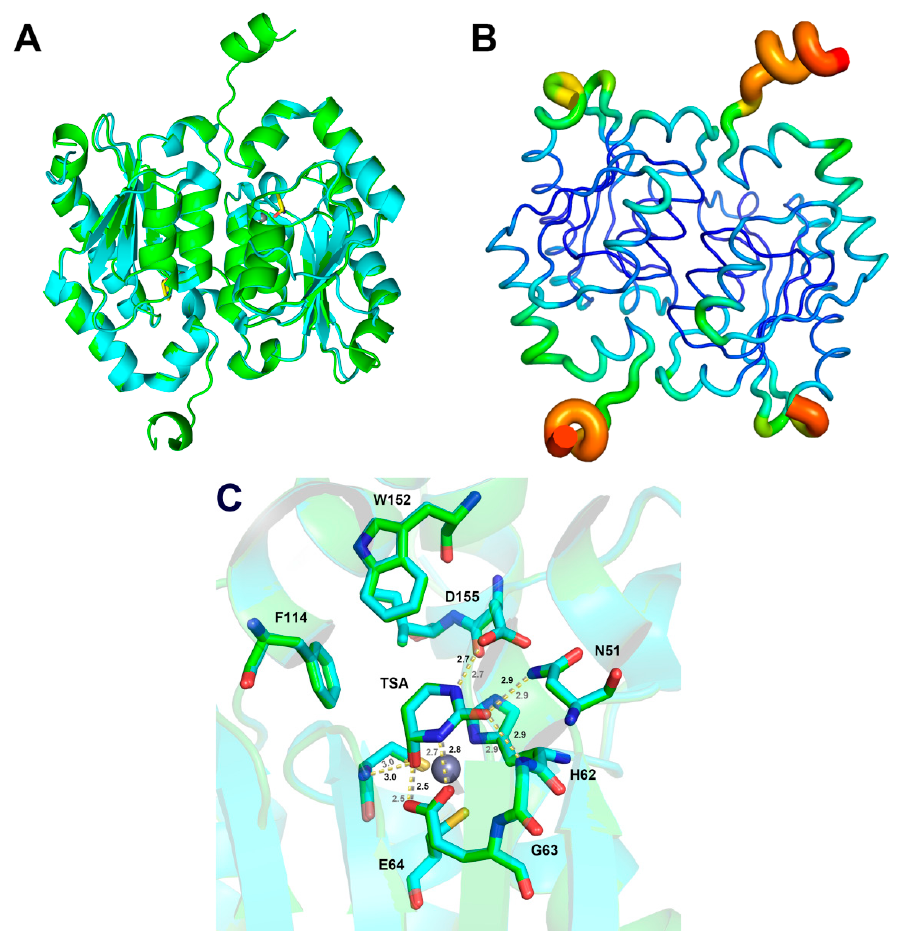
Figure 6. Overlay of the yCD-RQ-1/8SAH TSA complex structure (green, PDB ID: 8I3P) with the wt-yCD TSA complex (cyan, PDB ID: 1P6O): ( A ) overview of yCD-RQ-1/8SAH complex; ( B ) yCD-RQ-1/8SAH colored according to the B-factor with blue for the lowest B-factor and the red for the highest; ( C ) overlay of the two active sites. The hydrogen bond interactions in the active site of yCD-RQ-1/8SAH are shown by a yellow dashed line and those in wt-yCD are shown in grey. The distances between TSA and surrounding residues are labeled with color grey for yCD-RQ-1/8SAH and black for wt-yCD.